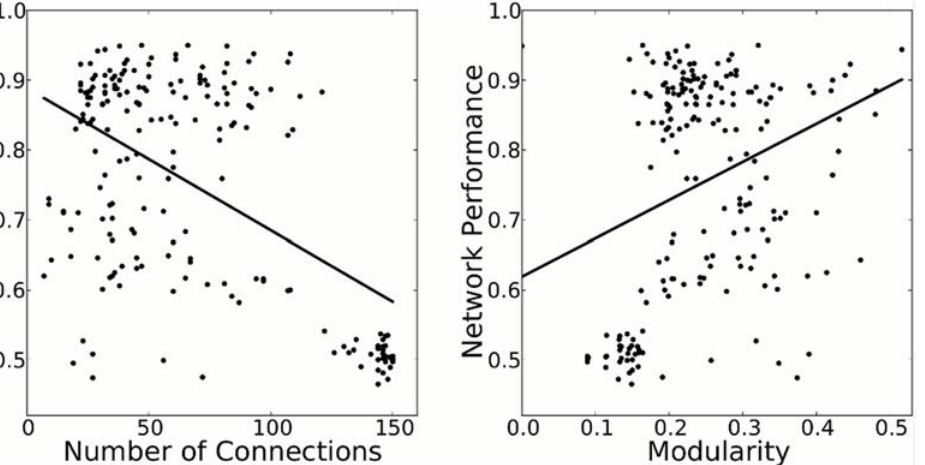
Fig 7. Performance is correlated with sparsity and modularity. Black dots represent the highest-performing network from each of the 100 experiments from both the PA and P&CC treatments. Both the sparsity ( p = 1.08 × 10 − 16 ) and modularity ( p = 1.19 × 10 − 5 ) of networks significantly correlates with their performance. Performance was measured in 80 randomly generated environments ( Methods). Significance was calculated by a t -test of the hypothesis that the correlation is zero. Notice that many of the lowest-performing networks are close to the maximum of 150